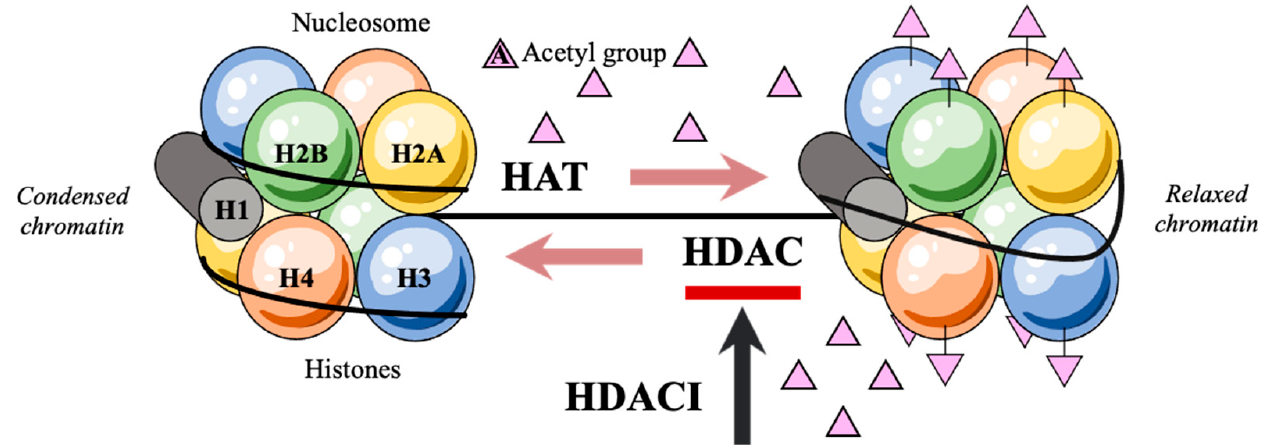
Figure 1. Post-translational acetylation decreases the affinity of histones for the negatively charged DNA, hence allowing DNA strands to uncoil and transcription to occur. Table 1. Overview of selected